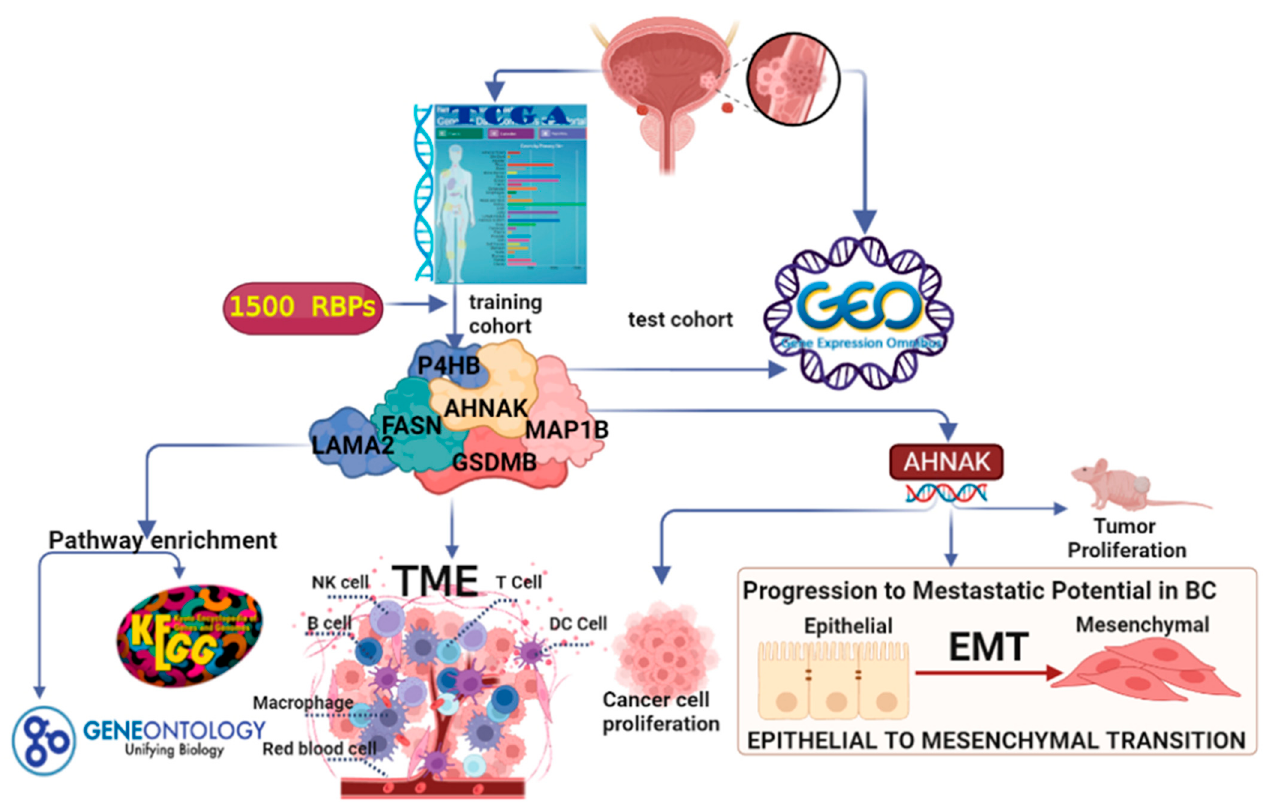
Figure 7. Flow chart of data processing in this study. TCGA, The Cancer Genome Atlas; GEO, Gene Expression Omnibus Database; GO, gene ontology; KEGG, Kyoto Encyclopedia of Genes, and Genomes; TIMER2.0 (Tumor Immune Estimation Resource